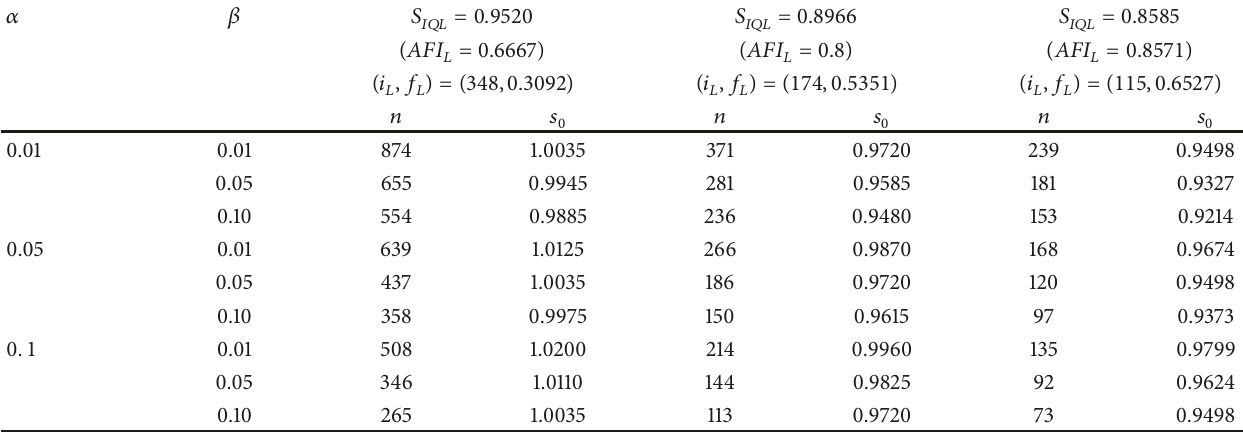
Table 4: The values of (𝑛,𝑠 0 ) at 𝑆 AOQL = 1.2485 ( AOQL = 0.00018) and three levels of 𝑆 𝐼𝑄𝐿 (𝐴𝐹𝐼 𝐿 ) for 𝛼 = 0.01, 0.05, and 0.1 and 𝛽 = 0.01, 0.05, and 0.1 .